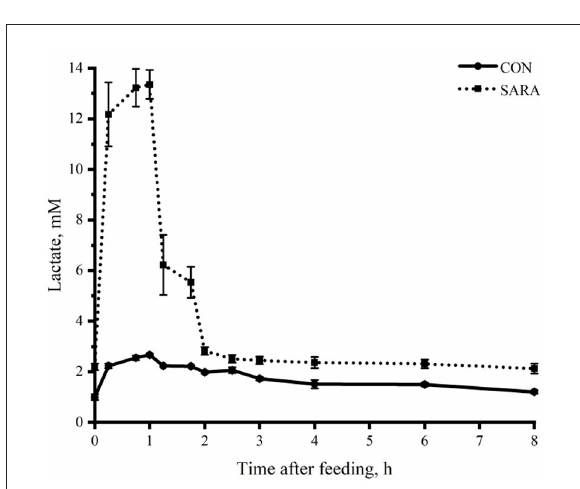
FIGURE3 The dynamic variation of lactate concentration in the rumen fluid of goats under normal (CON) or SARA condition. Data were expressed as mean ± SEM ( n = 6). Treatment P < 0.001, Time P < 0.001, Treatment * Time P < 0.001.